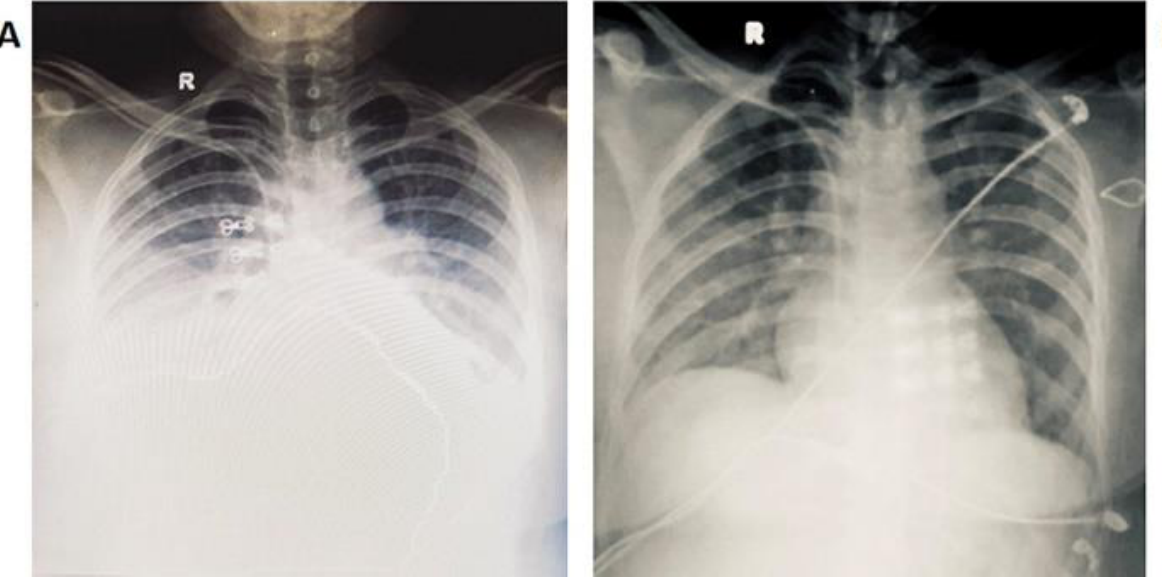
Figure 1 : From left to right: Chest X-ray showing left lower zone consolidation (1A), resolved consolidation after treatment